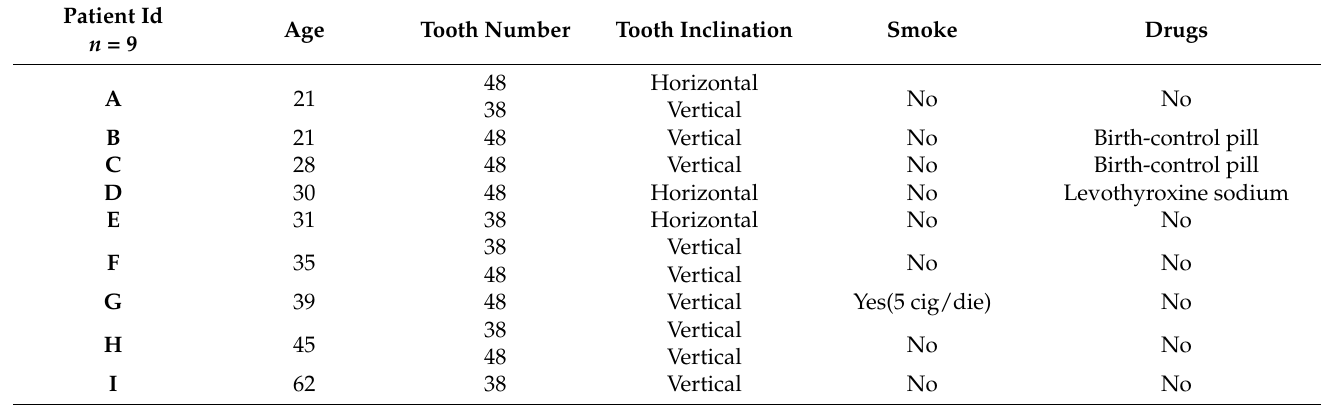
Table 1. Patients-related features (all females, all ASA